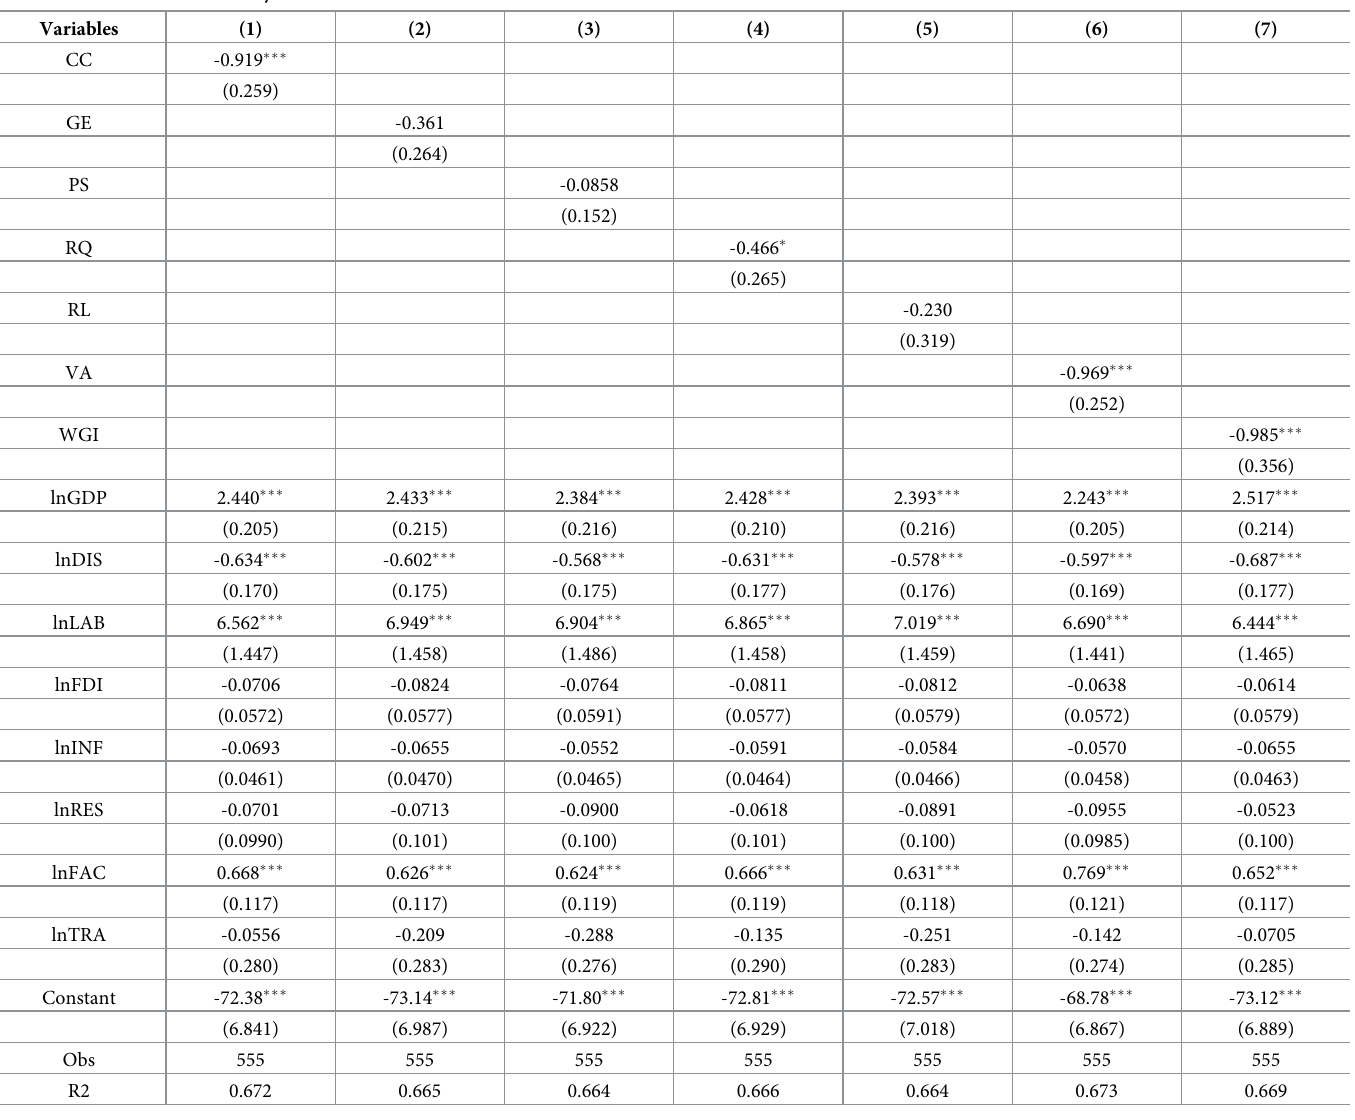
Table 3. Results of estimation by fixed effects